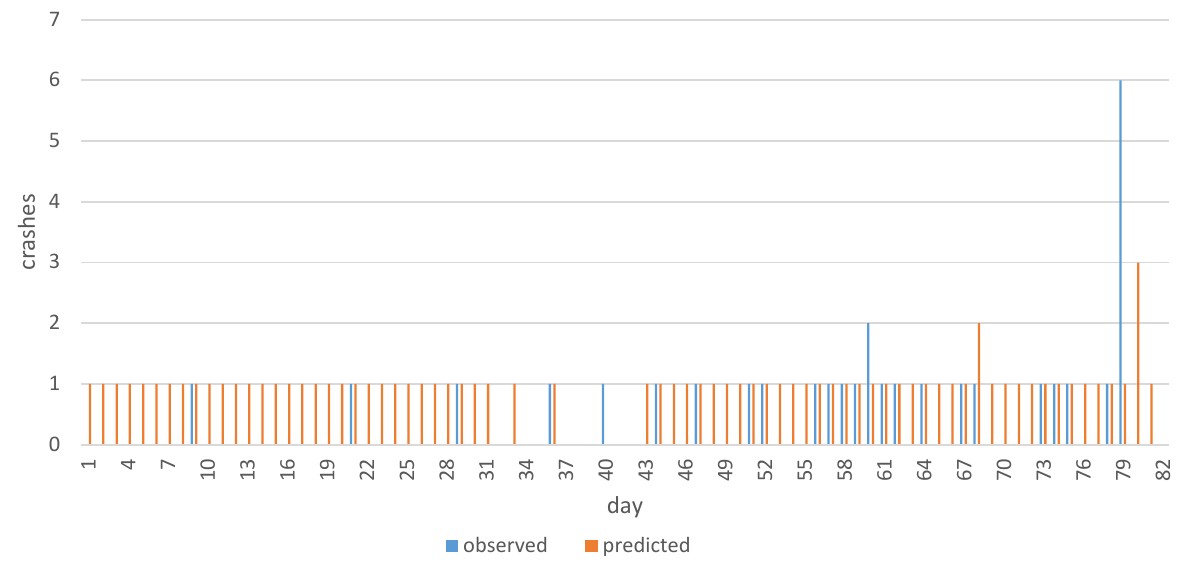
Figure 7. Prediction in Nantung direction of NB Count Data Model. Figure 9. Prediction in Nantung direction of NB Count Data Model. Figure 9. Prediction in Nantung direction of NB Count Data Model.